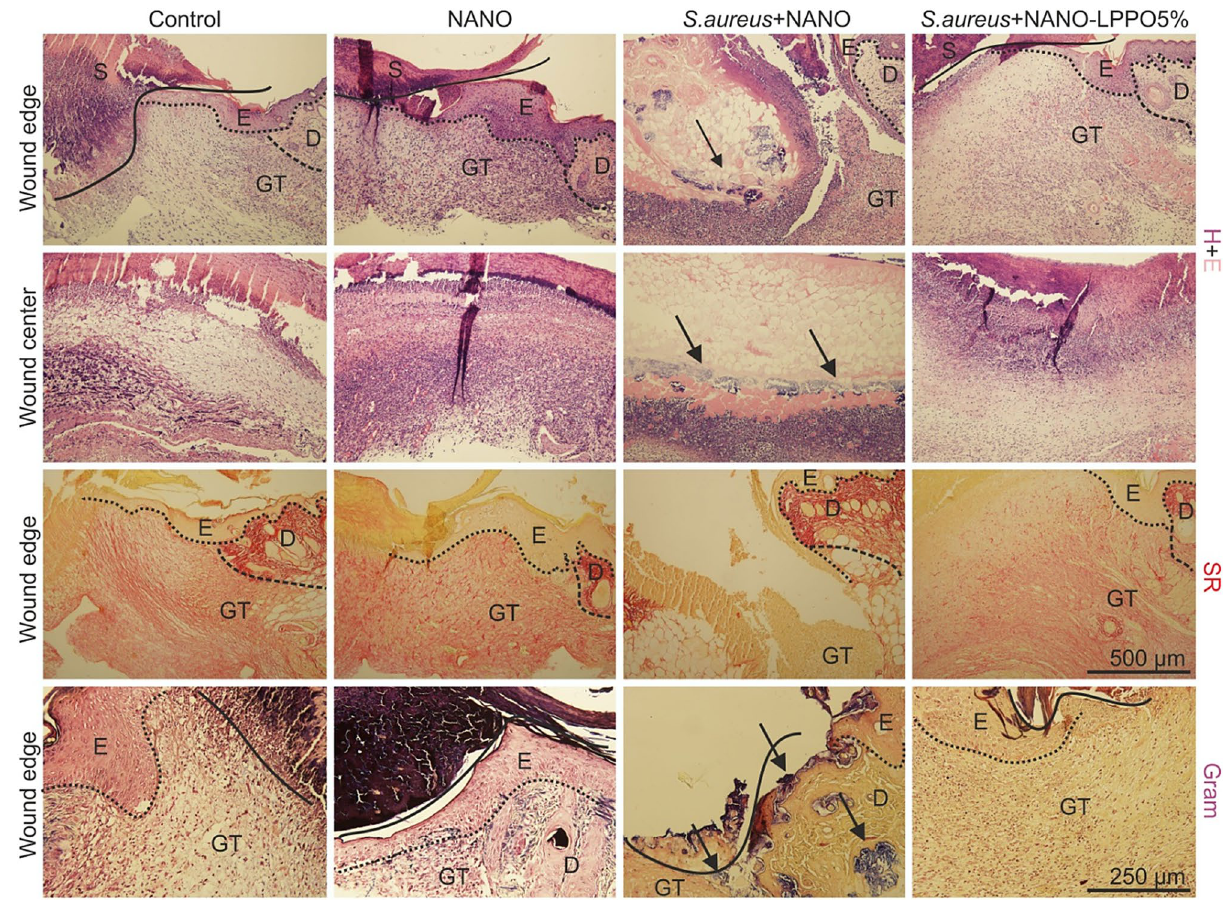
Figure 8. Histological photographs of skin wounds at day 7 post-surgery. Sections were stained with hematoxylin–eosin (H + E; arrows show the presence of bacterial infection), Sirius red (SR) and Gram (arrows show the presence of gram-positive bacterial infection) staining ( D dermis, E epidermis, GT granulation tissue, S scab; scale 250